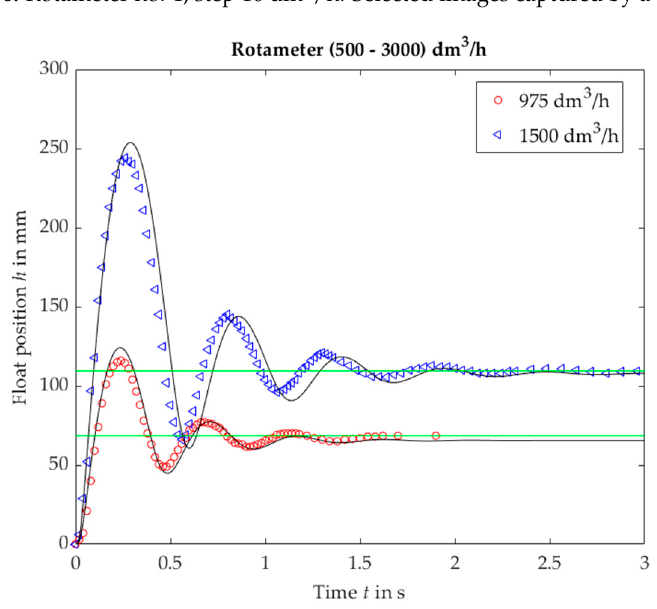
Figure 7. Rotameter no. 5, plumb bob. Float position h vs. time t for a step response, experimental (black solid lines) and calculated (markers).